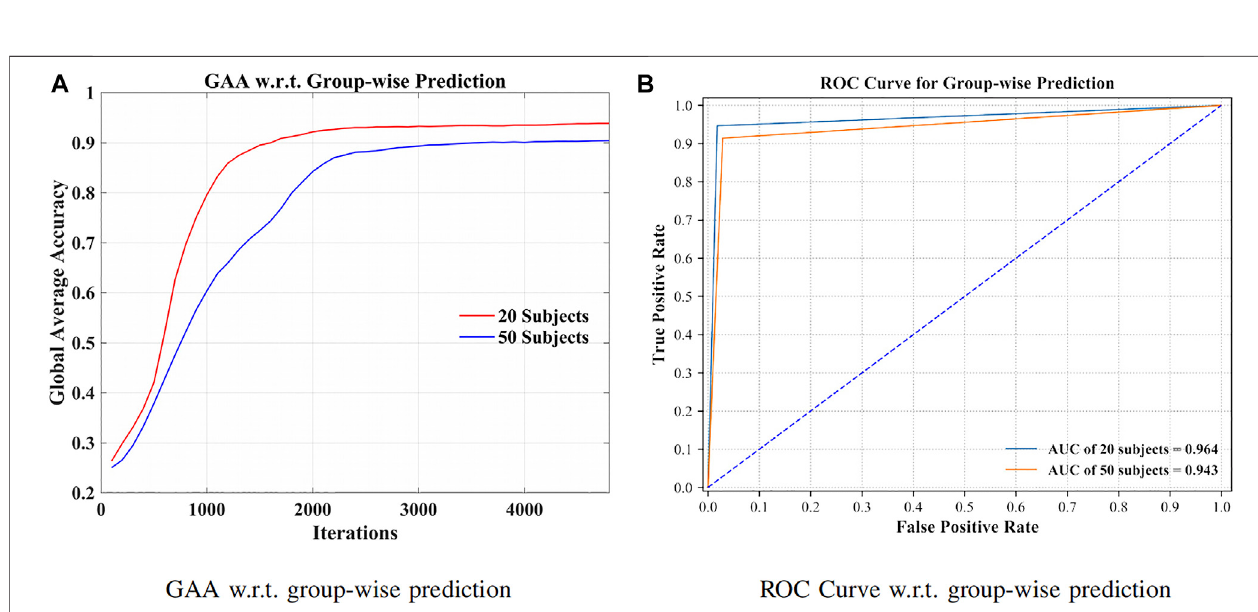
FIGURE 6 | GAA and receiver operating characteristic curve (ROC curve) for 20 and 50 subjects, separately. (A) GAA w.r.t. groupwise prediction. (B) ROC curve w.r.t. groupwise prediction.